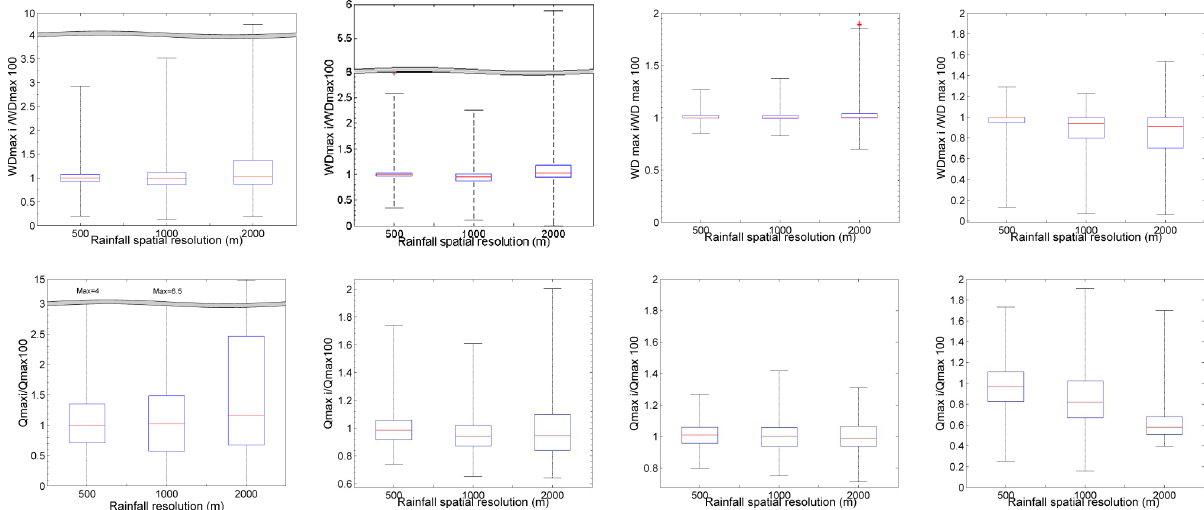
Figure 8. Boxplots of the normalised maximum water depths (top panel) and runoff peaks (bottom panel) computed for all nodes in the model, for Events 1 (left) to 4 (right).